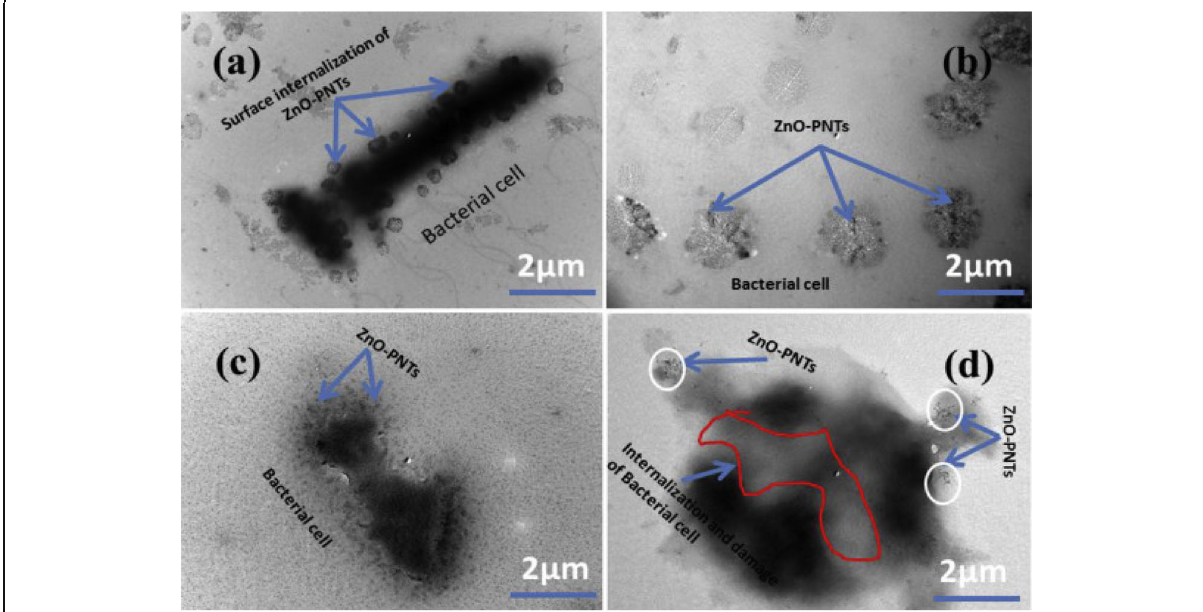
Fig. 8 Typical Bio-TEM images of peanut-shaped ZnO with ( a ) E. coli , ( b ) K. pneumoniae , ( c ) S.Typhimurium , ( d ) S. aureus . Reproduced from ref. [59] with permission from